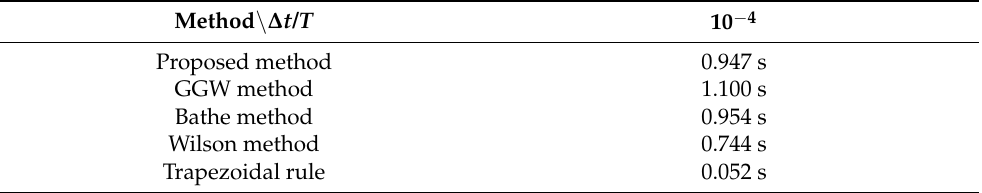
Table 2. Computational time of different methods for Problem